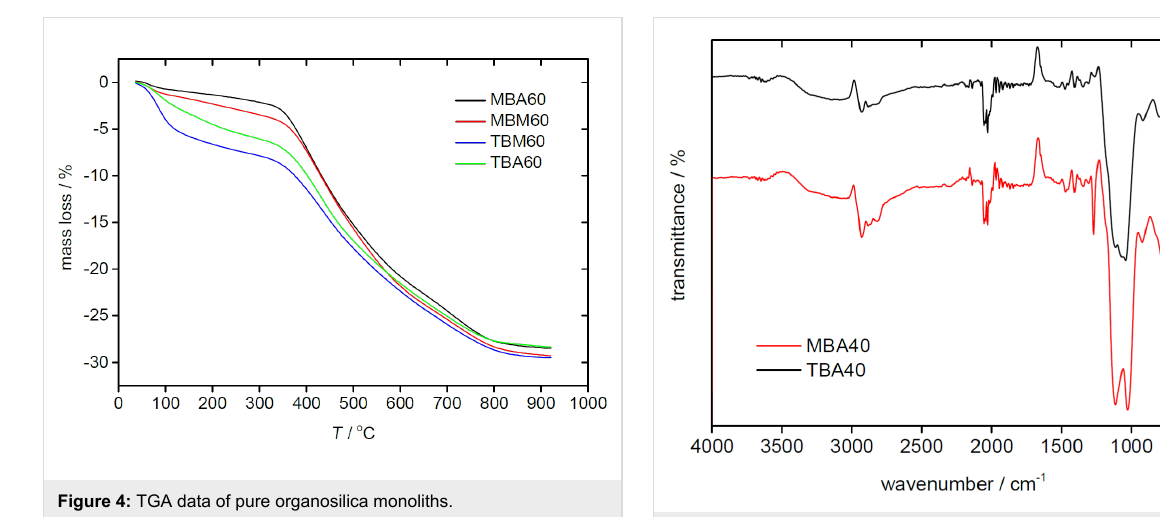
presence of rather small pores and a relatively narrow pore size distribution [37]. Analysis of the SAXS data using the Porod- approach [37-40] confirms this, although pore sizes determined via SAXS are slightly larger than the values determined from BJH analysis, Table